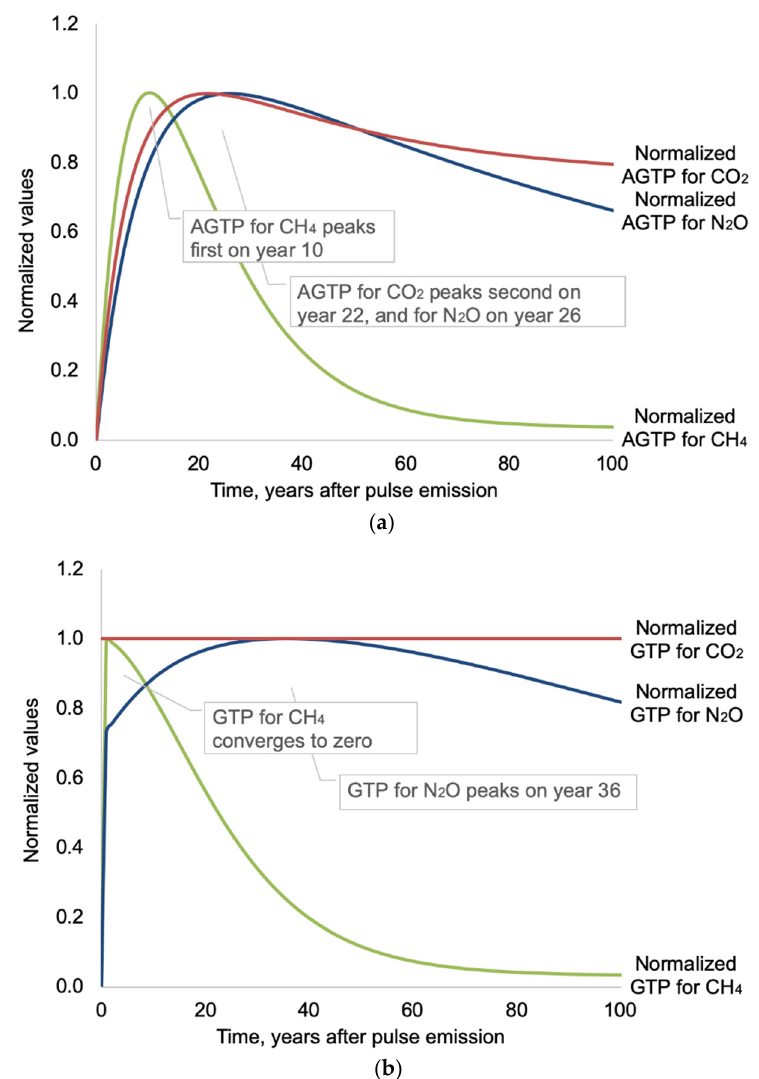
Figure 6. Normalized ( a ) absolute global temperature change potential (AGTP) ( b ) GTP values as a response to emission of CO 2 , N 2 O, and CH 4 at year zero. The values are normalized to the maximum value of the corresponding AGTP or GTP of each gas, unitless.